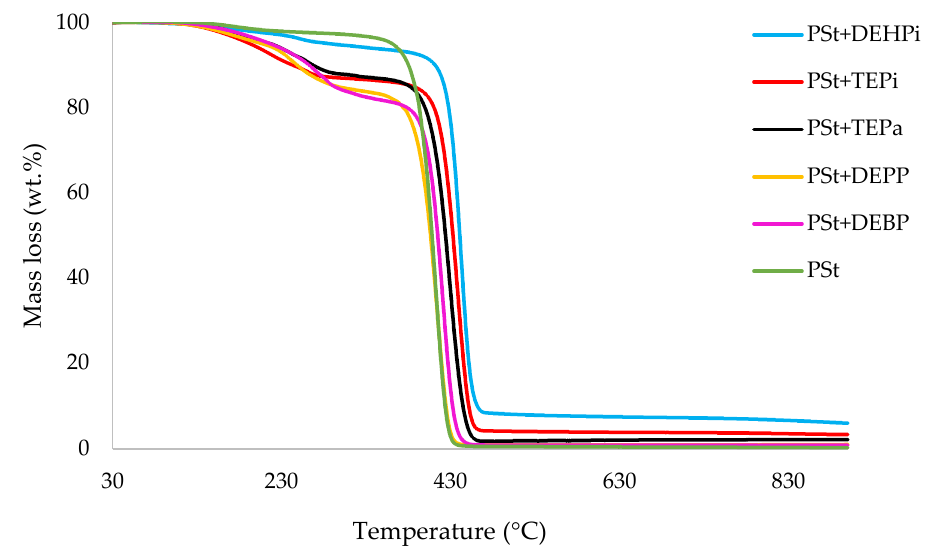
Figure 2. An overlay of the TGA curves of the PSt-based materials with liquid additives, at 10 °C min −1 in nitrogen, from 30 to 900 °C.